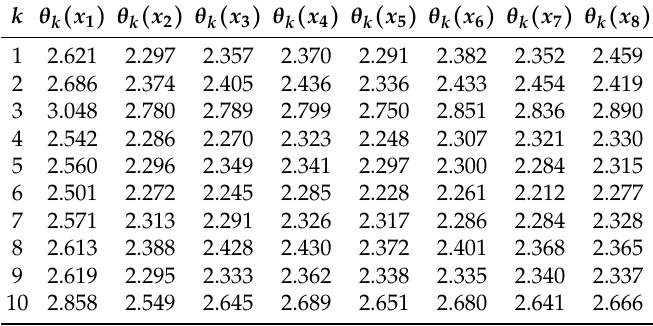
Table A2. Average values of the ohmic resistance (in m Ω ) of 44 vented lead–acid (VLA) batteries for the eight electrolyte